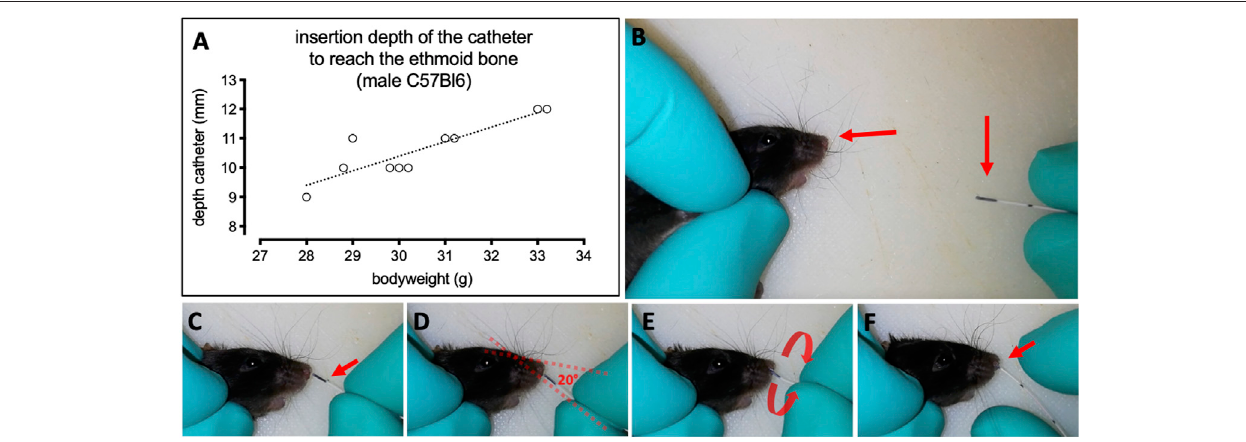
FIGURE 2 | Insertion depth of the neonatal catheter and procedure of olfactory region-speci fi c intranasal delivery in a C57Bl6 mouse cadaver. (A) Individual insertiondepthsofaneonatalcatheterinthemurinenosefortheintranasalapplicationattheolfactoryregion.Thecorrelationbetweentheinsertiondepthoftheneonatal catheter and the weight of the individual animals was signi fi cant (*** p < 0.0009, r 2 (cid:1) 0.77, n (cid:1) 10). (B – F) Sequence of the re fi ned region-speci fi c intranasal delivery targetingtheolfactoryregion. (B) Themouseiskeptinasupinepositionwhiletheheadisgently fi xedwithonehand.Thenostrilmustbeaccessible(arrowhead)and the prepared catheter (arrowhead) kept in the other hand. (C) Note the colored pattern at the tip of the catheter as indicator of how far the catheter is inserted. (D) The catheter iscarefullyinserted into the nostril with aminimal angle of20 ° to target the correct meatus. (E ) During insertion the catheter must be rotated gently to advance it through the tight nasal cavity. (F) Once the catheter reaches the ethmoid turbinates (olfactory region) it cannot be advanced gently anymore. The colored part of the catheter is now completely introduced into the nasal cavity